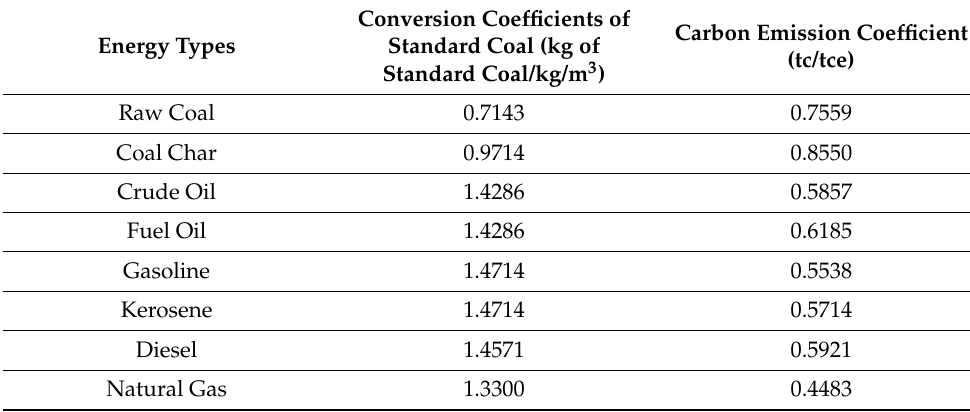
Table 1. Calculation coefficients of energy consumption carbon